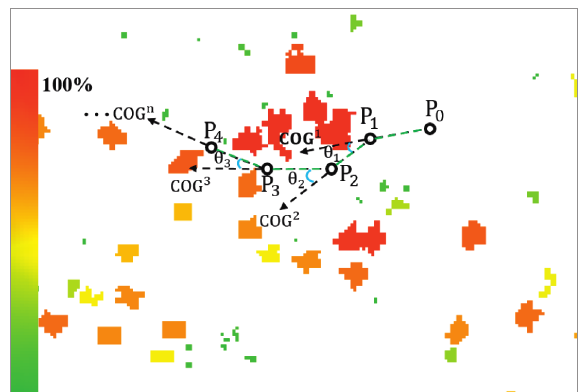
Figure 9: Optimization procedure for near-field route optimization model.